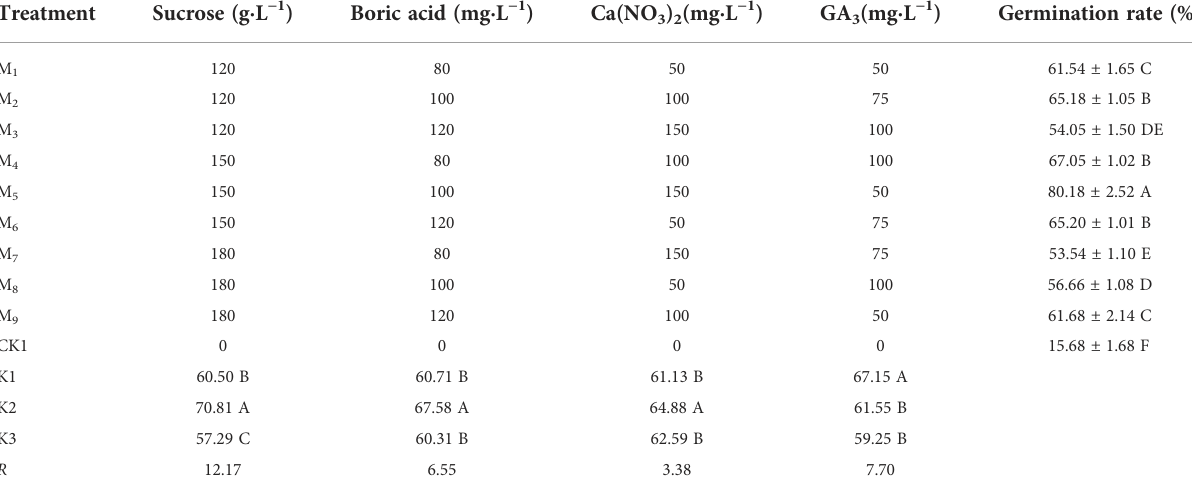
TABLE 1 Germination media of E. racemosa pollen grains in an orthogonal design assay.